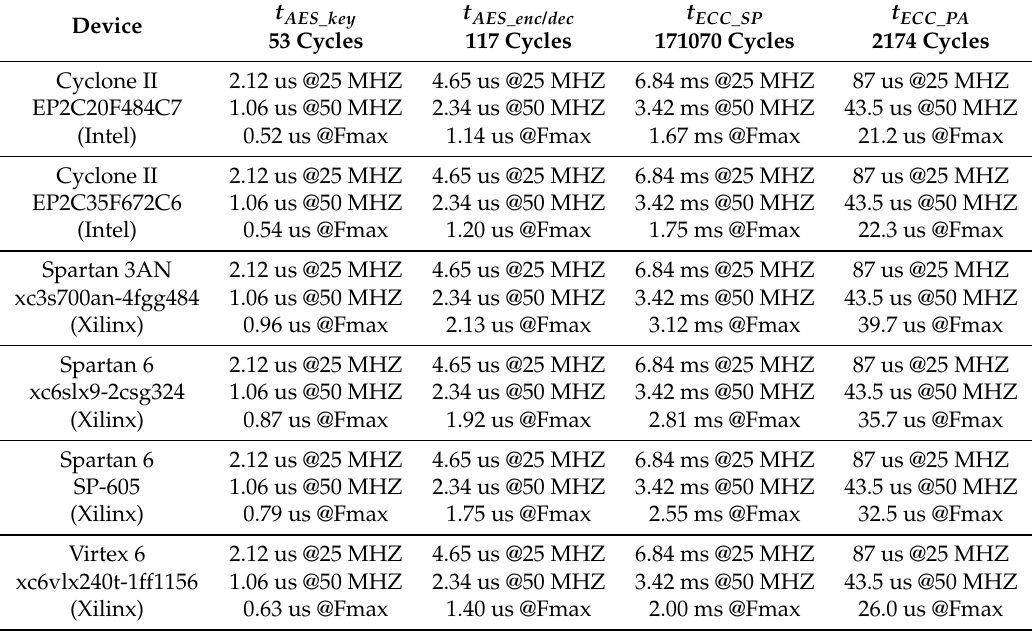
Table 5. Time required for completing each one of the available operations in ECC163AES128 core on different